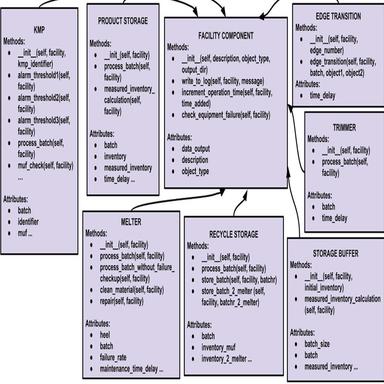
Other than subclasses for sub-processes in the fuel fabrication process, the key measurement point class and the edge transition class also inherit functionalities from the facility component class. Major methods and attributes for each class are described above.